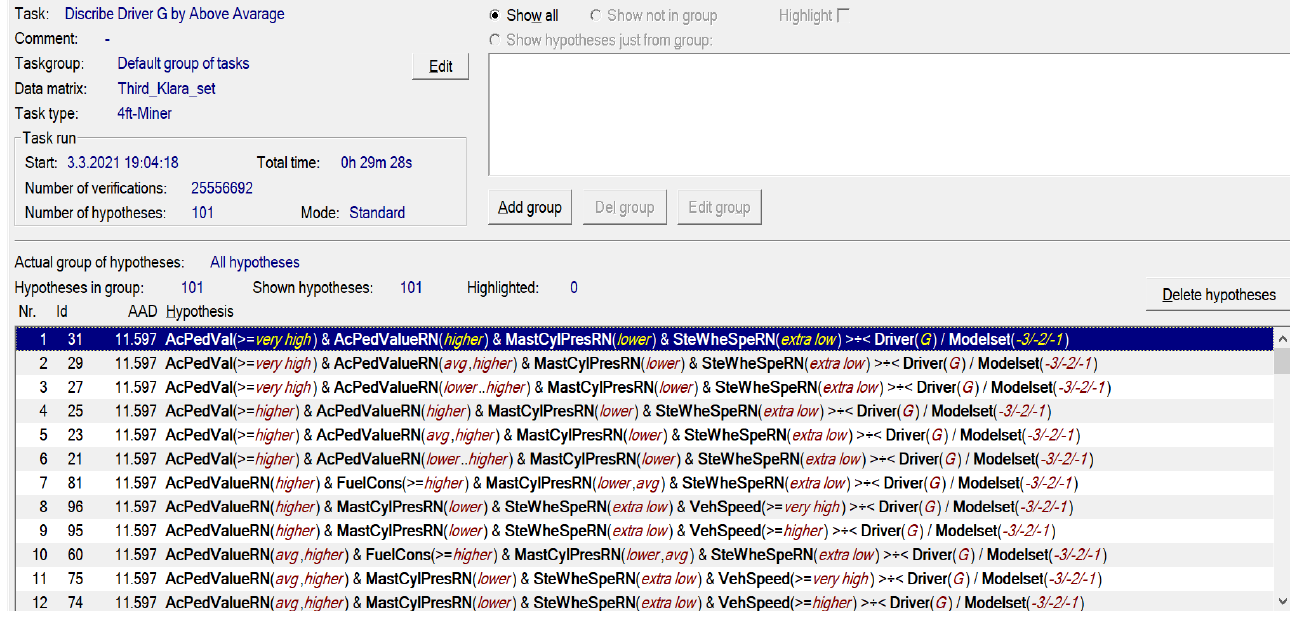
Figure 2. Screenshot on LISpMiner results for driver G.